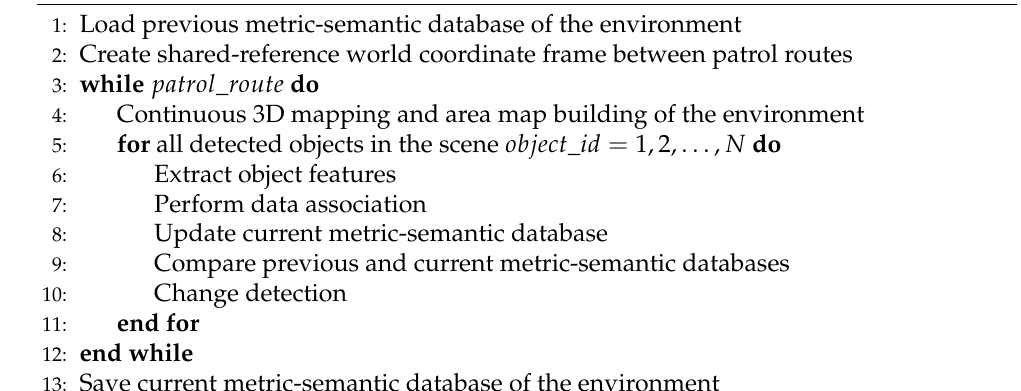
Algorithm 2 Change detection using the metric-semantic database of the environment.